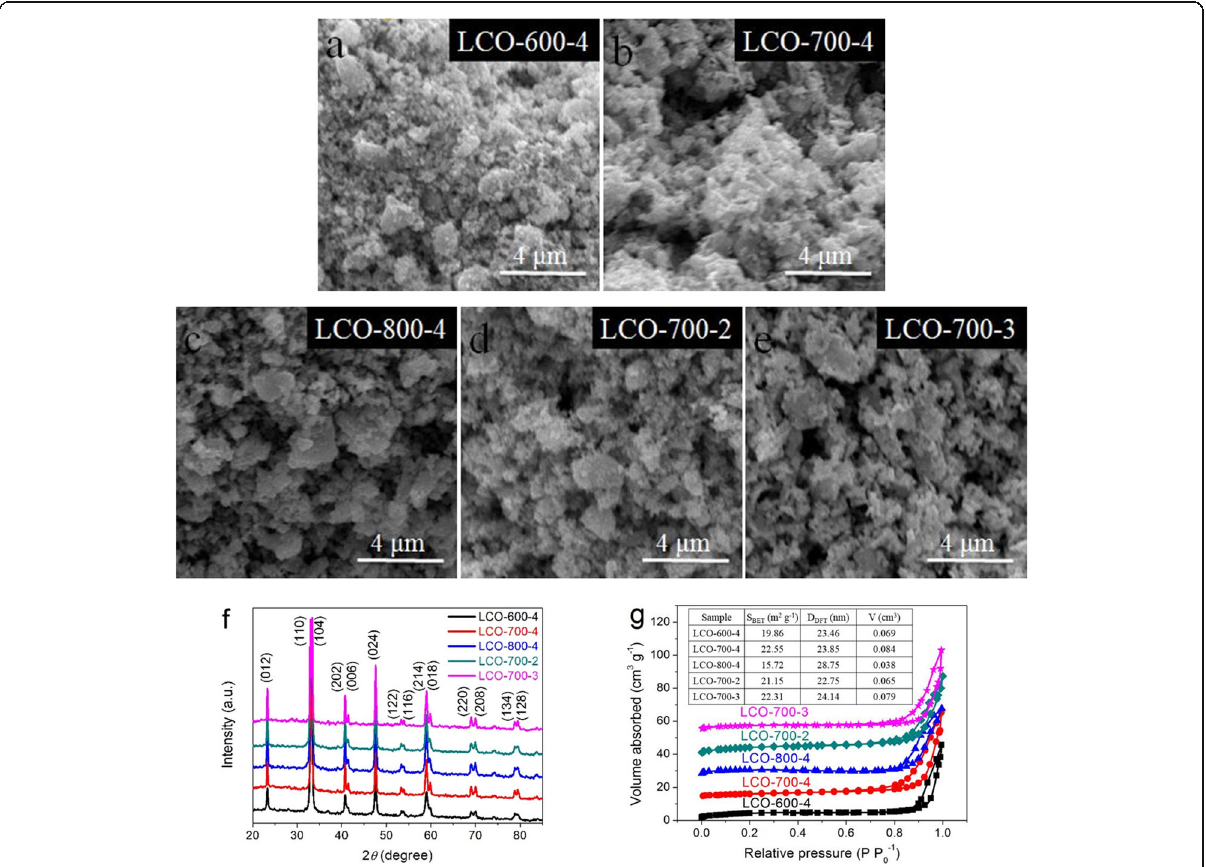
Fig. 1 a – e SEM images, f XRD patterns, and g N 2 adsorption-desorption isotherms of the as-prepared LCOs samples at different calcination temperatures and